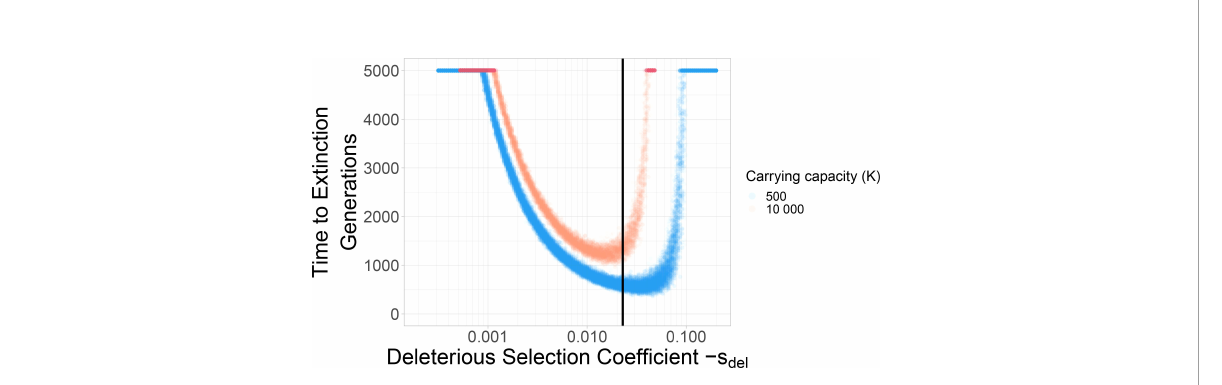
FIGURE 1 Deleterious selection coef fi cients of intermediate size minimize the extinction time. Two different carrying capacities are shown: 500 and 10 000. Each dot represents a simulation run. With larger carrying capacity K=10000 the time to extinction increases. The black vertical line indicates the selection coef fi cient (S del =-0.023) used in the standard parameter set throughout the rest of the